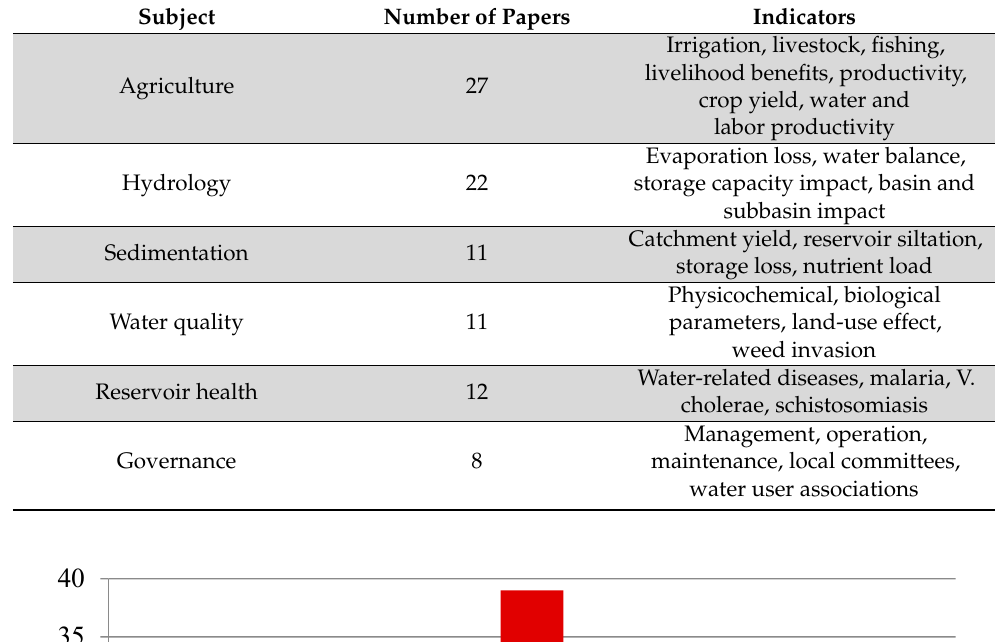
Table 2. Indicators considered under each subject area.